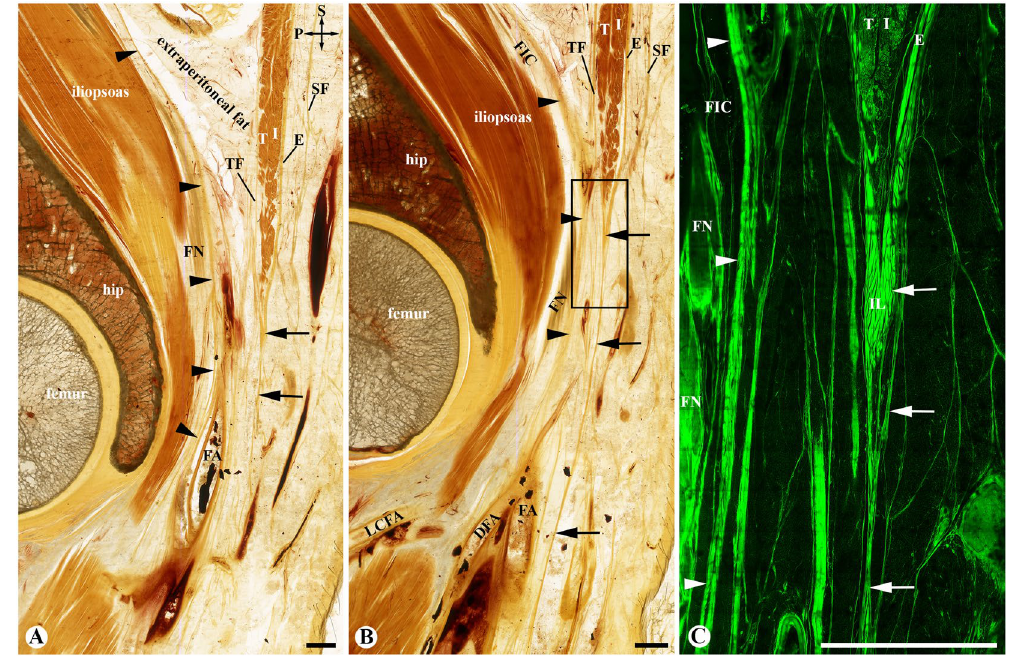
Figure 3. The origin of the fascia lata and its relationship with the fascia iliaca and femoral nerve. ( A , B ) two adjacent sagittal sections at the level of the hip joint; ( A) is medial to ( B , C ) the mirror confocal image of the box in ( B ) The aponeurotic fibers from the external oblique (E), internal oblique (I) and transversus (T) abdomines form the inguinal ligament (IL) and its inferior prolongation which contributes the fascia lata (arrows). The fascia iliaca (arrowheads) borders the fascia iliaca compartment (FIC), covers the femoral nerve (FN) and contributes to the posterior wall of the femoral vascular wall. DFA: deep femoral artery; FA: femoral artery; LCFA: lateral circumflex femoral artery; SF: Scarpa’s fascia; TF: transversalis fascia; Crossed-arrows: orientation of the figure (P: posterior; S: superior); Bars = 5